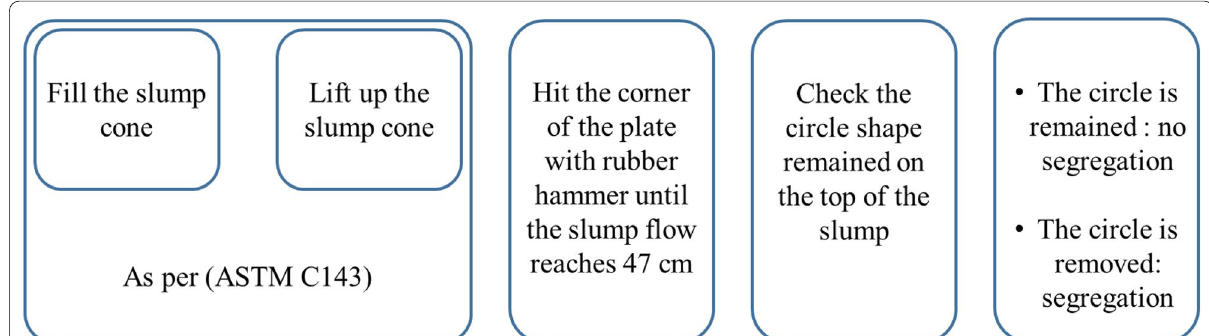
Fig. 2 Schematic process of segregation evaluation for concrete mixture suggested by Maruya et al. (2013).